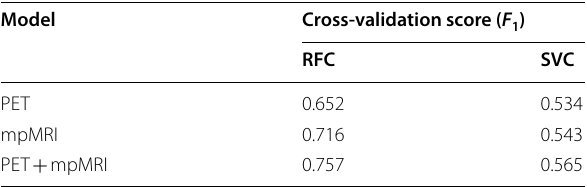
Table 2 Cross-validation performance of the tumour detection models